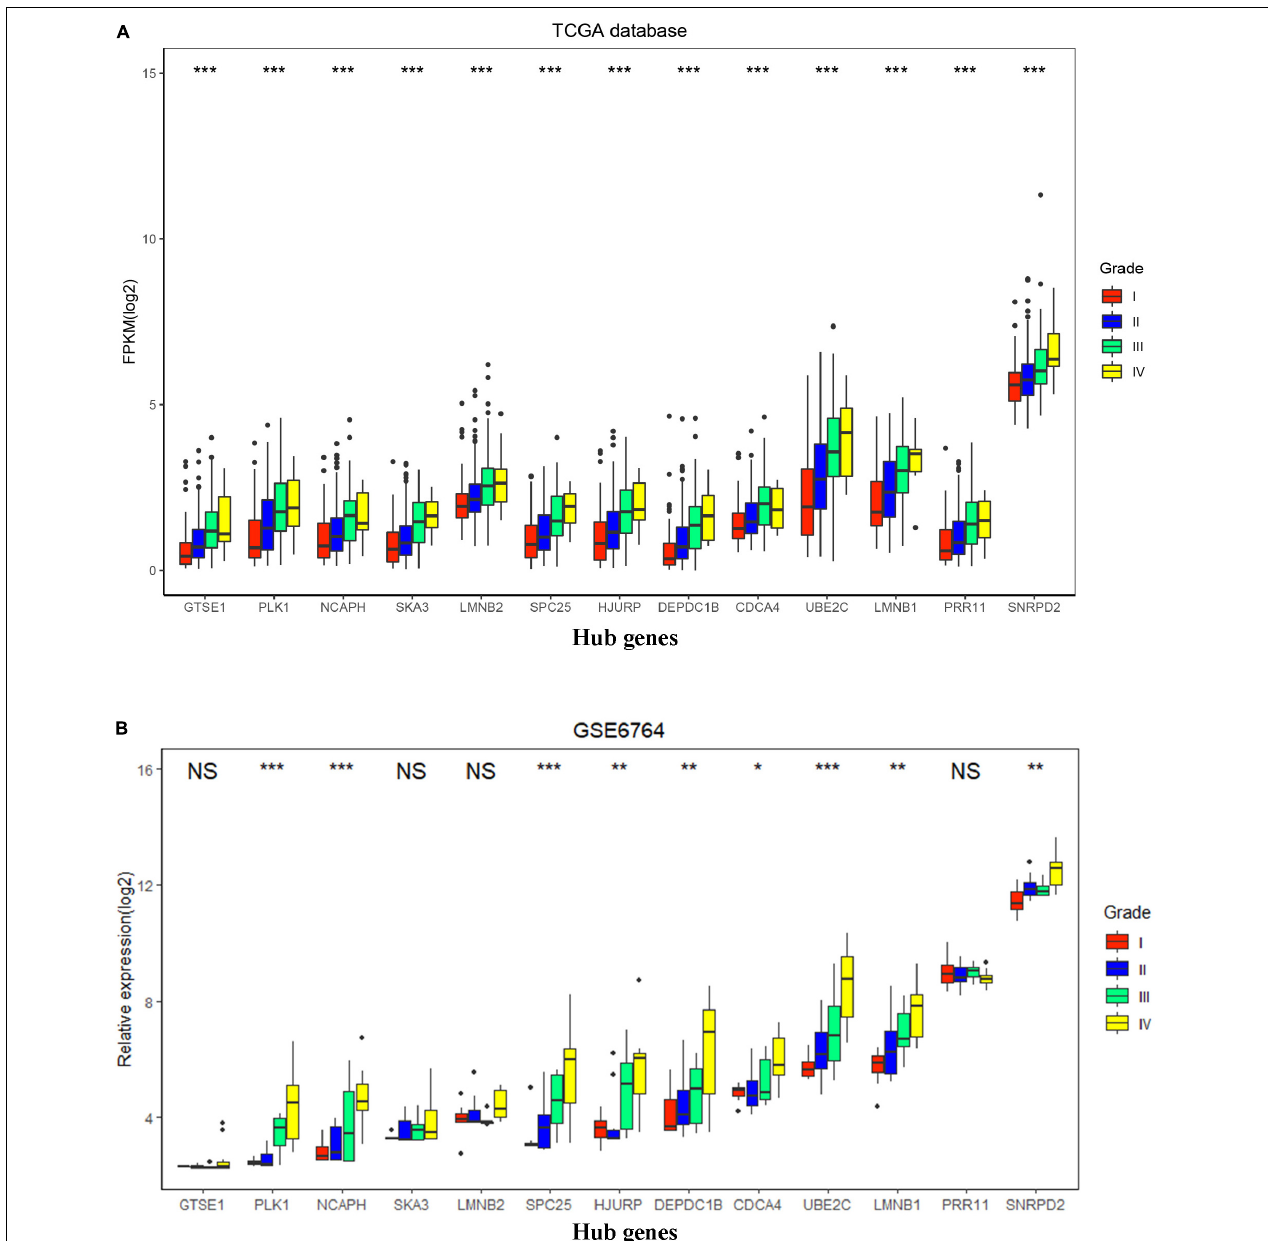
FIGURE 8 | Hub gene expression in different histologic grades in The Cancer Genome Atlas (TCGA) database and GSE6764. (A) Boxplot of 13 hub genes in histologic grades I–IV in the TCGA database. P -value was calculated by one-way ANOVA. *** p < 0.001. (B) Boxplot of 13 hub genes in histologic grades I–IV in GSE6764. P -value was calculated by one-way ANOVA. * p < 0.05, ** p < 0.01, *** p < 0.001; NS, no